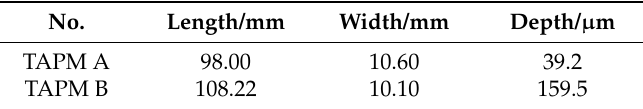
Table1. Specifications of two TAPMs.